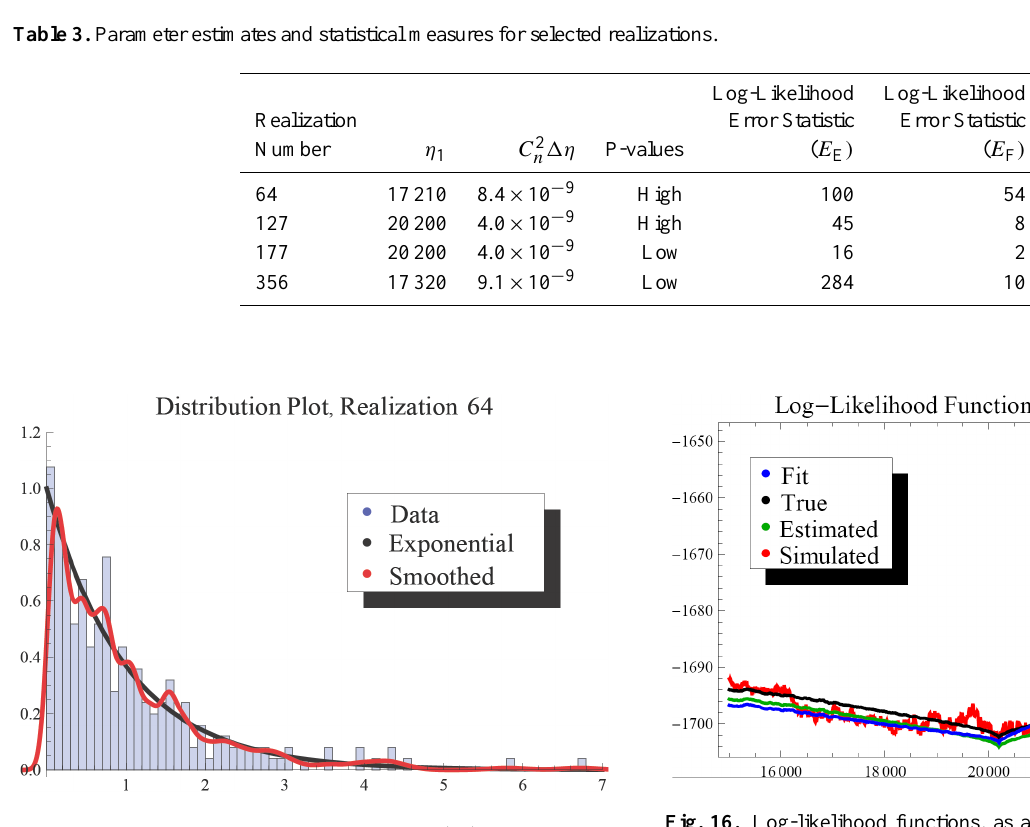
Fig. 15. Distributions plots of the ratios in Eq. (45), for realization number 64.